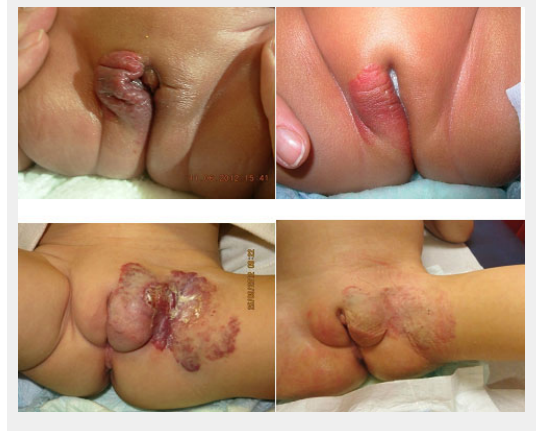
Two examples of genital area haemangiomas complicated by ulceration. Left: before treatment. Right: after treatment with propranolol (2